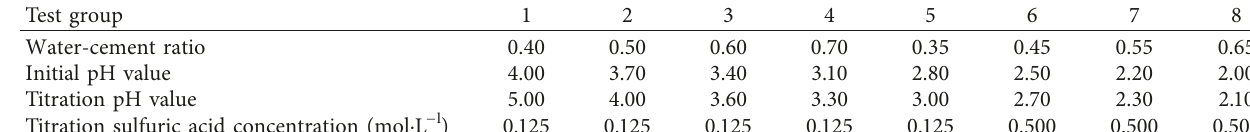
0.40. (b) pH (cid:30) 2.20, w / c (cid:30)